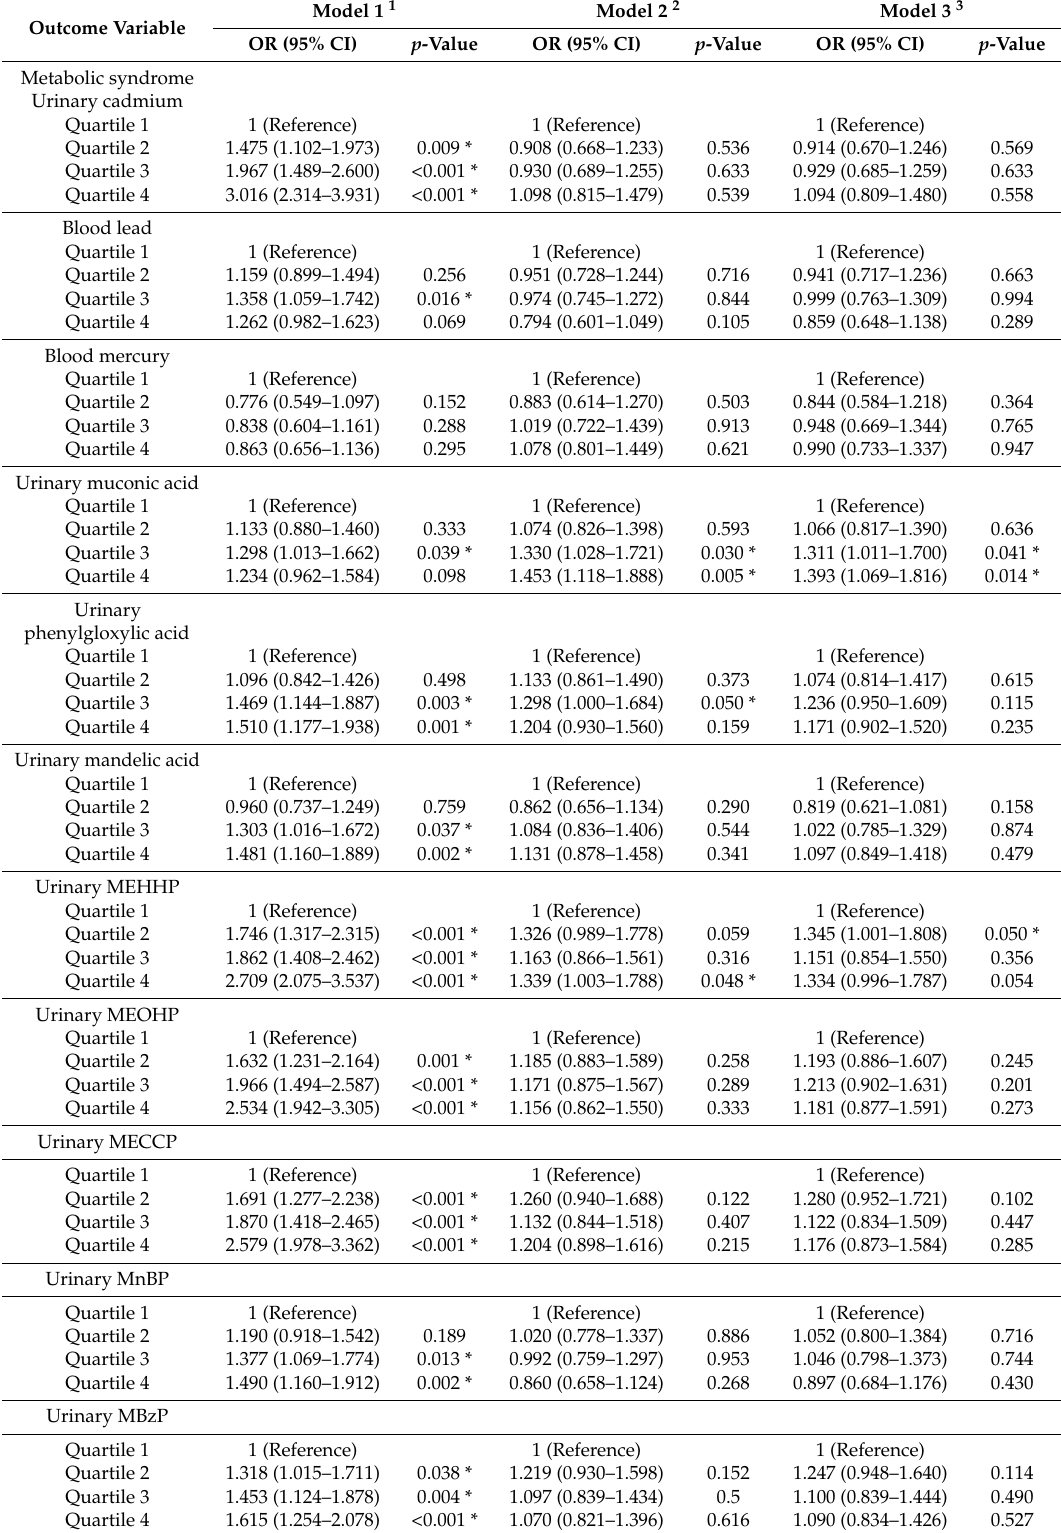
Table 3. Metabolic syndrome (MetS) risk (Odds Ratio (OR)) based on hazardous materials. Outcome